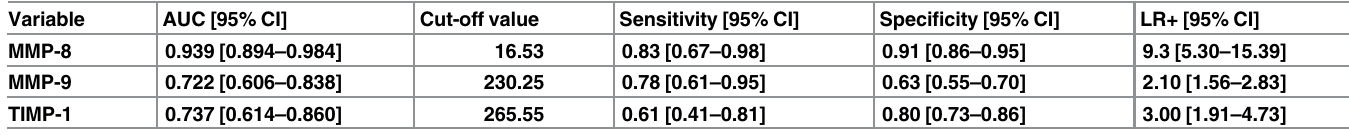
Table 3. Statistical characteristics of MMP -8, -9 and TIMP-1 describing their ability to detect severe acute